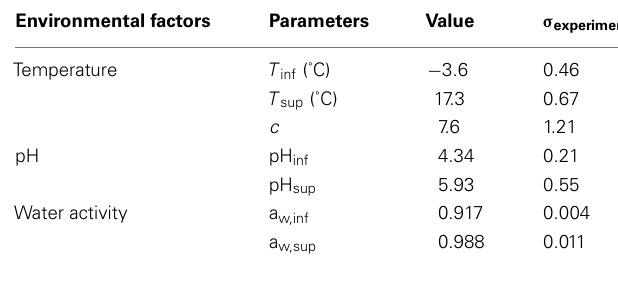
Table 1 | Parameters of the models describing the evolution of the single-cell growth probability of L. monocytogenes with environmental